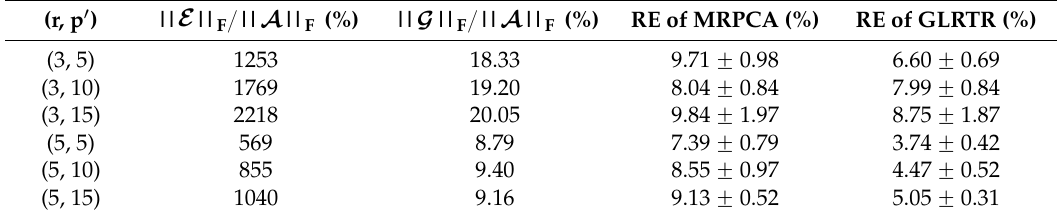
Table 1. Comparison of experimental results on 50 ˆ 50 ˆ 50 tensors.